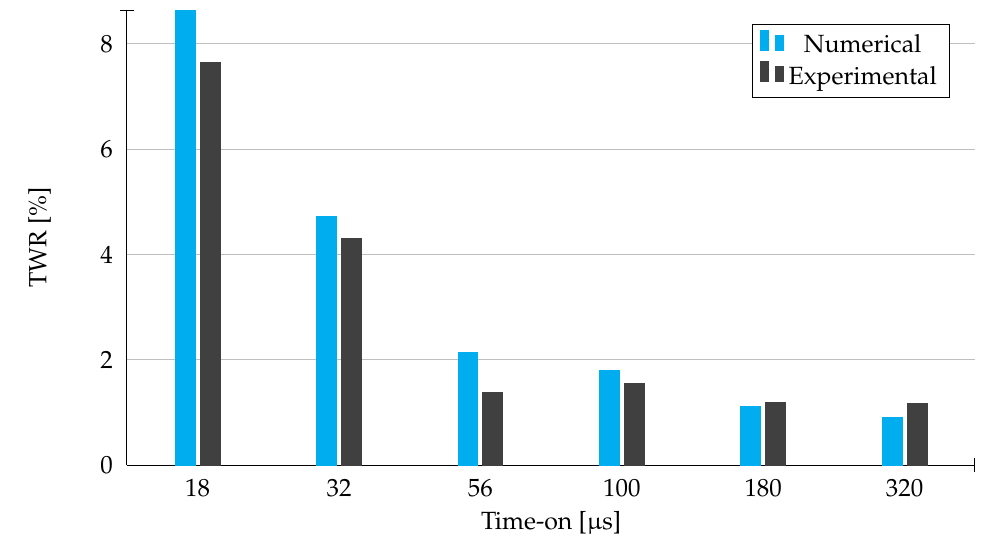
Figure 11. Tool Wear Ratio results obtained from experimental work and numerical simulation in